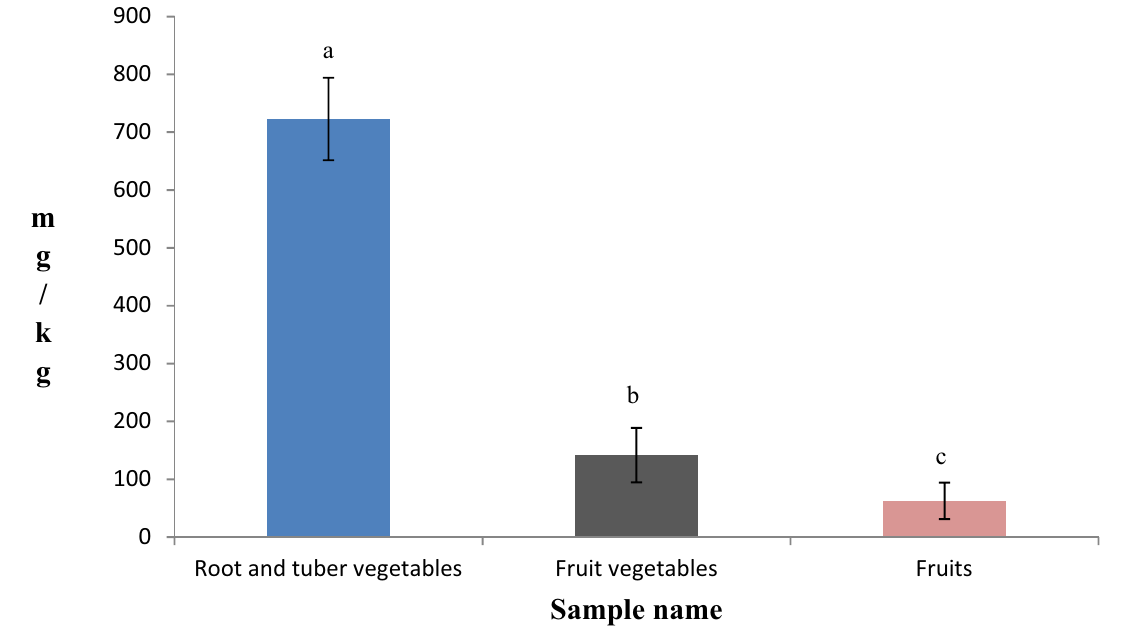
Figure 2. Nitrate levels in different tested root and tuber vegetables, fruit vegetables, and fruit samples. Error bars represent standard deviation. Columns that have the same letter are not significantly different at P-value =